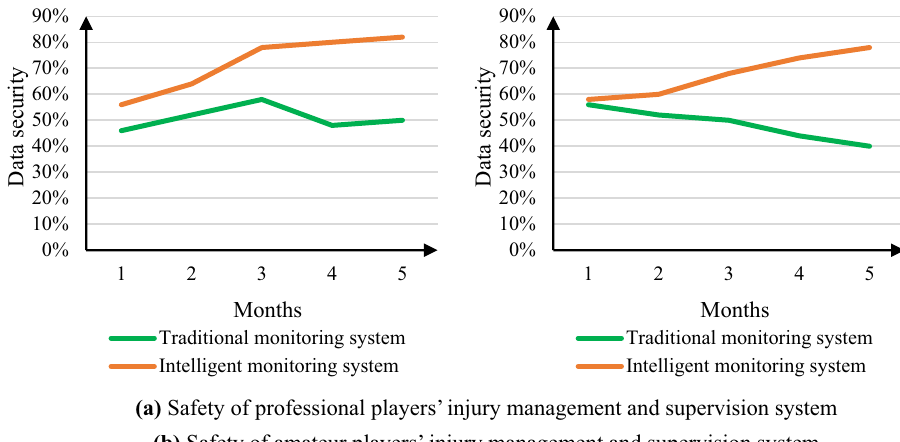
Fig. 5 Comparison results of system data